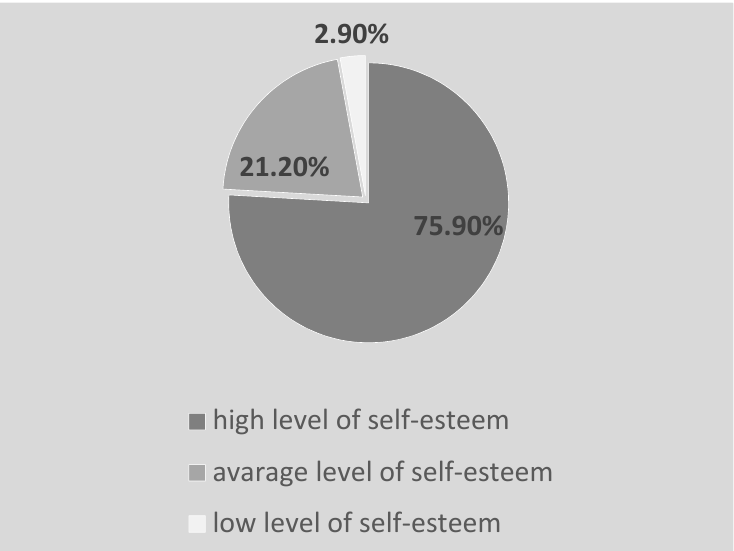
Figure 2. Self-esteem of the students participating in the study. A low level of satisfaction with life was declared by 27.0% of students (N = 83). The average level of satisfaction with life was 20.82 ± 5.72 points and was in the range of 5–35 points. The average result on the sten scale was 5.64 ± 2.00 points and was in the range of 1–10 points. Average results were obtained by 42.0% of the respondents and high results by 30.9% of the respondents (Figure 3).